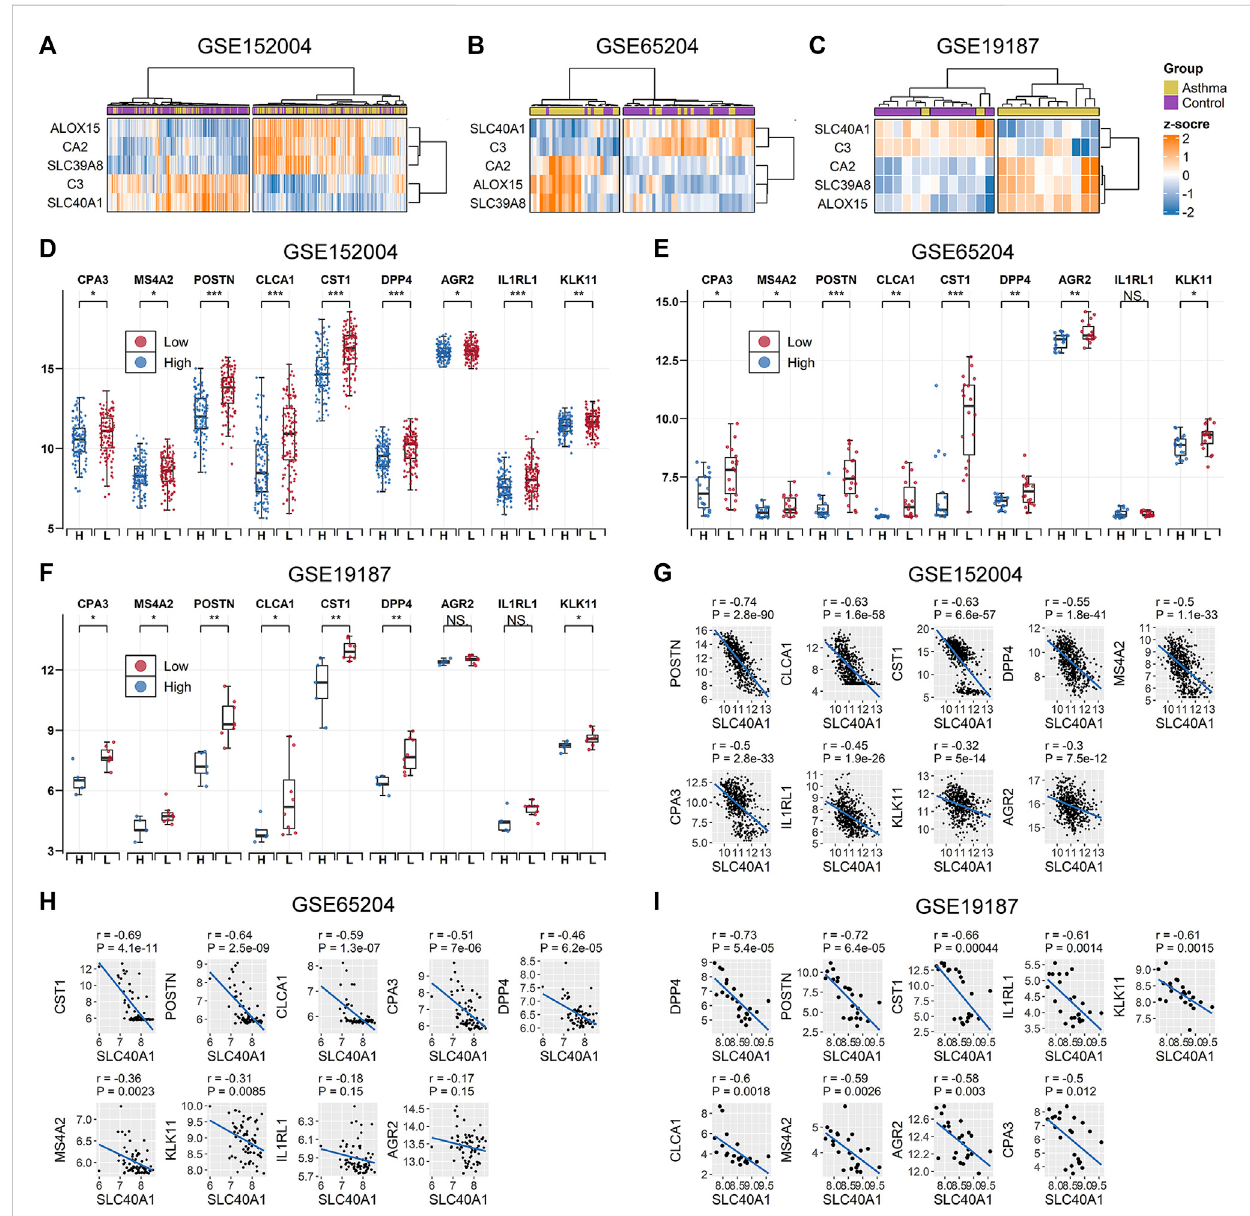
FIGURE 3 Association between SLC40A1 and type 2 airway in fl ammatory markers. Hierarchical clustering of all patients using common IMR DEGs distinguished allergic asthmatic patients from controls in (A) GSE152004, (B) GSE65024, and (C) GSE19187 datasets. Hierarchical clustering was performed using the “ ward.D ” method and “ Euclidean ” distance. Comparison of gene expression levels of nine T2 airway in fl ammatory markers between SLC40A1 high-expression group (H) and SLC40A1 low-expression group (L) of all asthmatic patients in (D) GSE152004, (E) GSE65024, and (F) GSE19187. Statistical signi fi cance was assessed using Wilcoxon rank-sum test. Asterisks indicated p values for SLC40A1 high-expression versus SLC40A1 low-expression. * p < 0.05, ** p < 0.01, *** p < 0.001. Scatter plots of SLC40A1 vs. type 2 airway in fl ammatory marker expression in